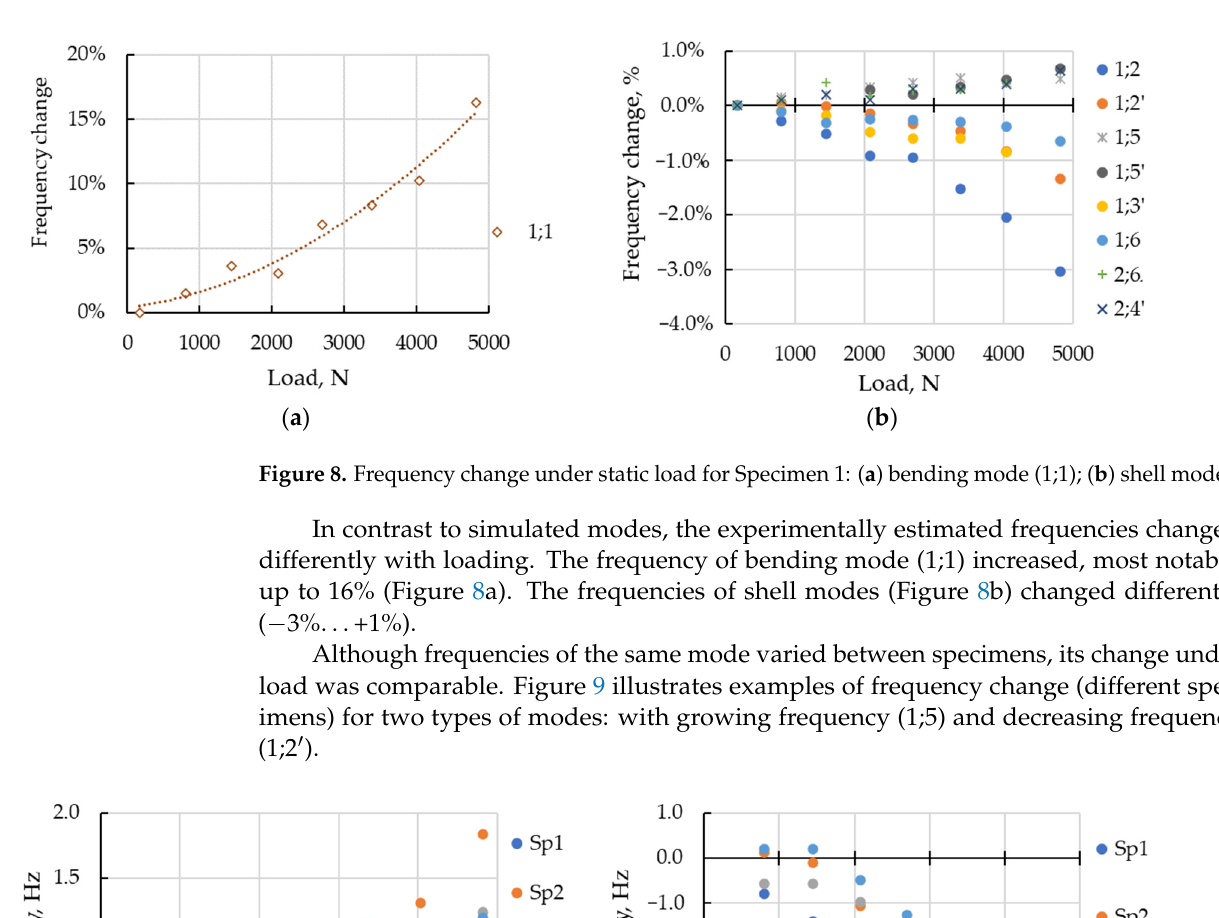
Figure 8. Frequency change under static load for Specimen 1: ( a ) bending mode (1;1); ( b ) shell modes.